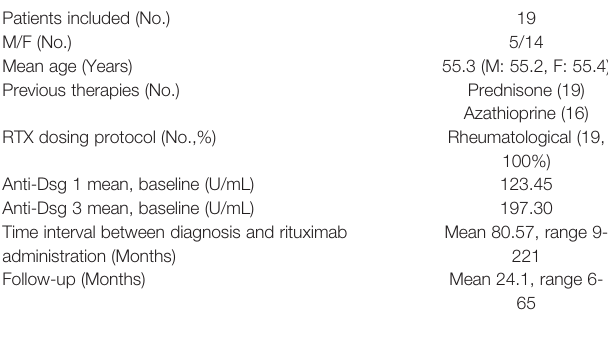
TABLE 1 | Baseline characteristics of patients. Patients included